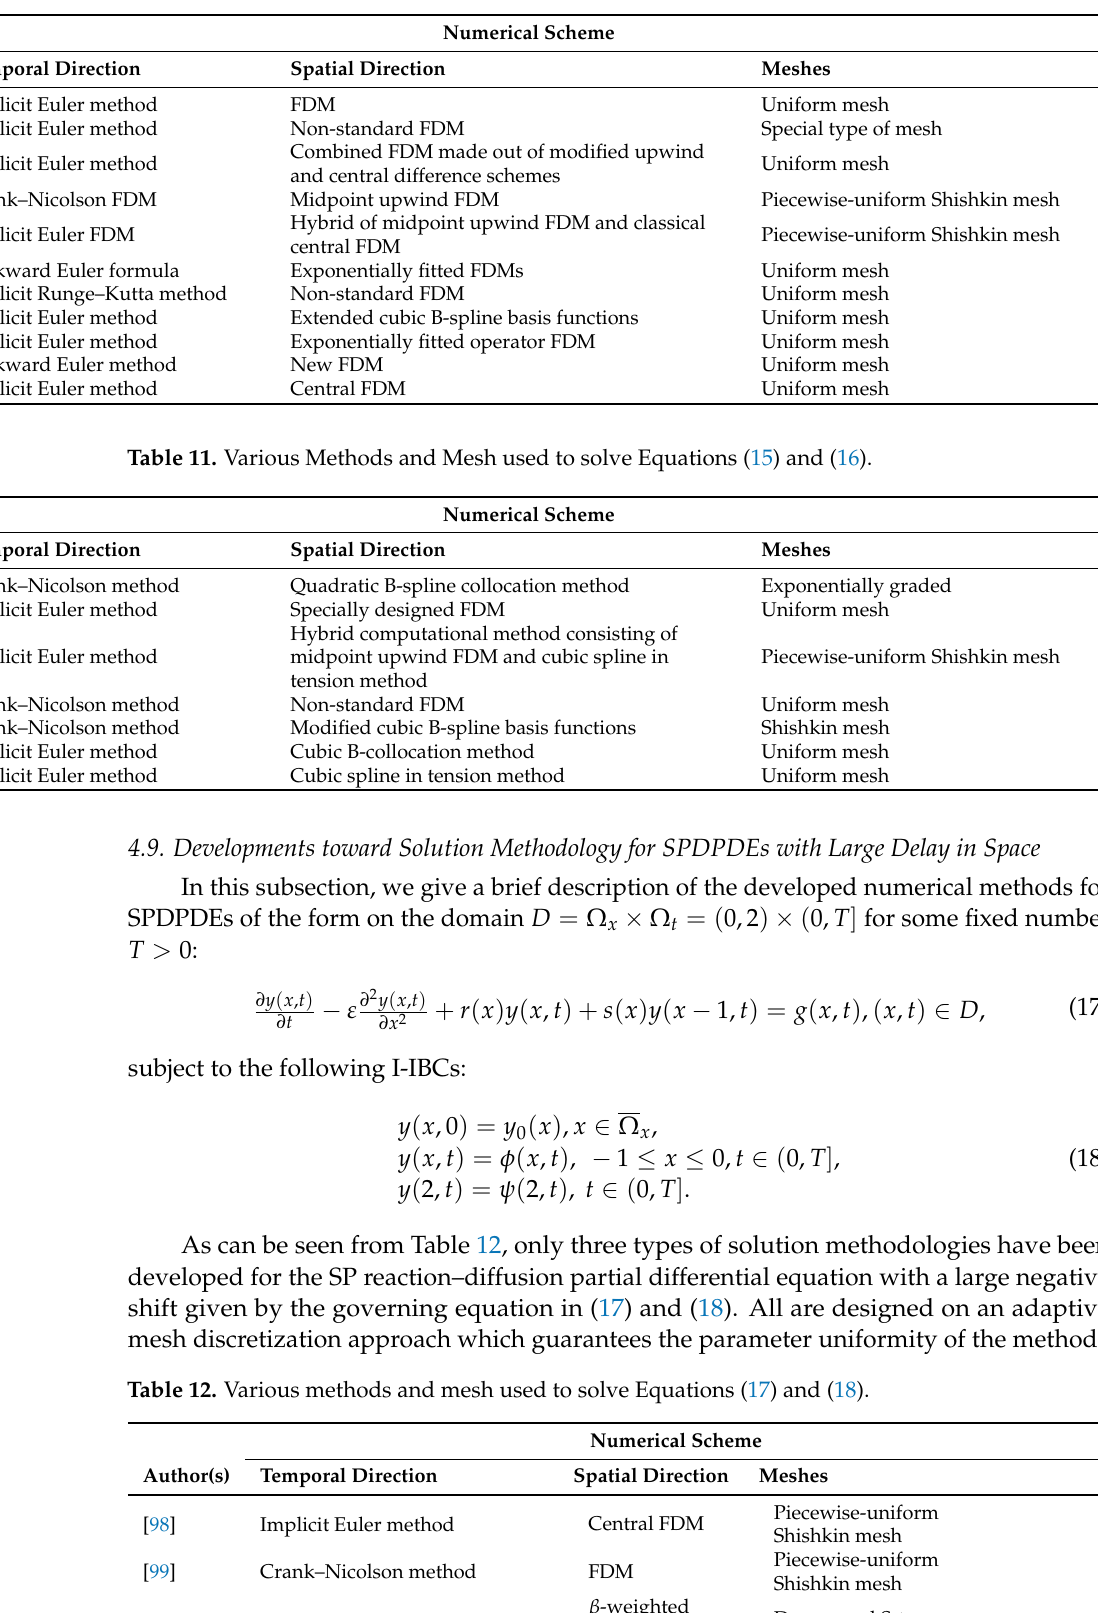
Table 10. Various methods and mesh used to solve Equations (15) and (16).